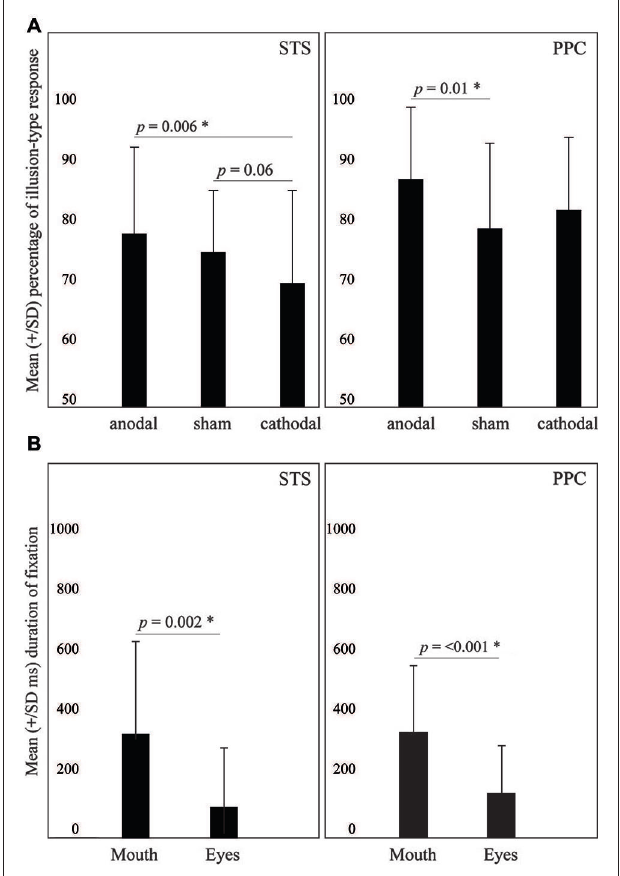
FIGURE 2 | (A) Effects of tDCS on the McGurk effect. (B) Duration of fixation on the mouth or the eyes. Values are described as mean ± SD.